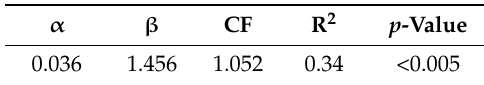
Table 1. Rating coefficients for Equation (1), correction factor (CF), coefficient of determination (R 2 ), and significance ( p -value) for the Jiuzhou Station.